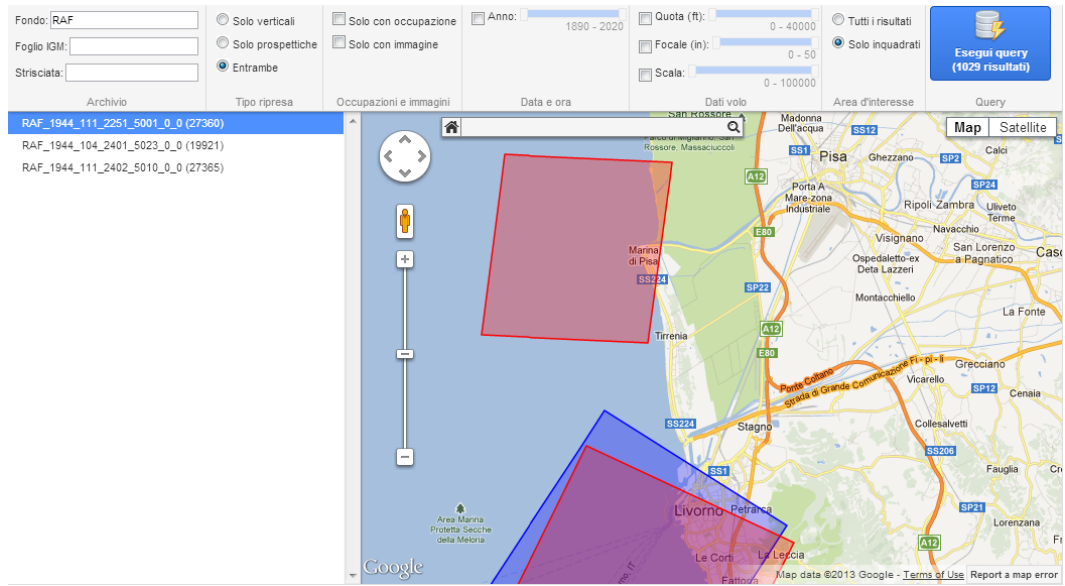
A screenshot of the interface of the custom WebGIS system developed for querying the GeoMemories